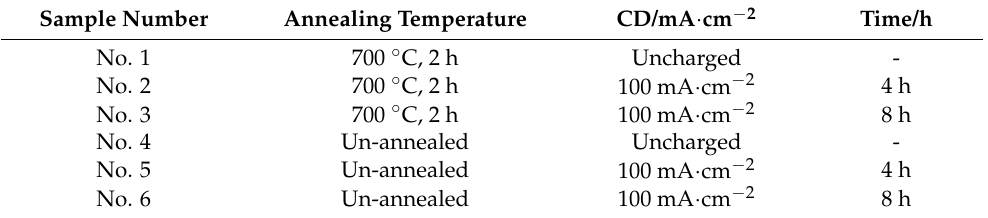
Table 1. Sample treatment conditions and electrolytic hydrogen charging